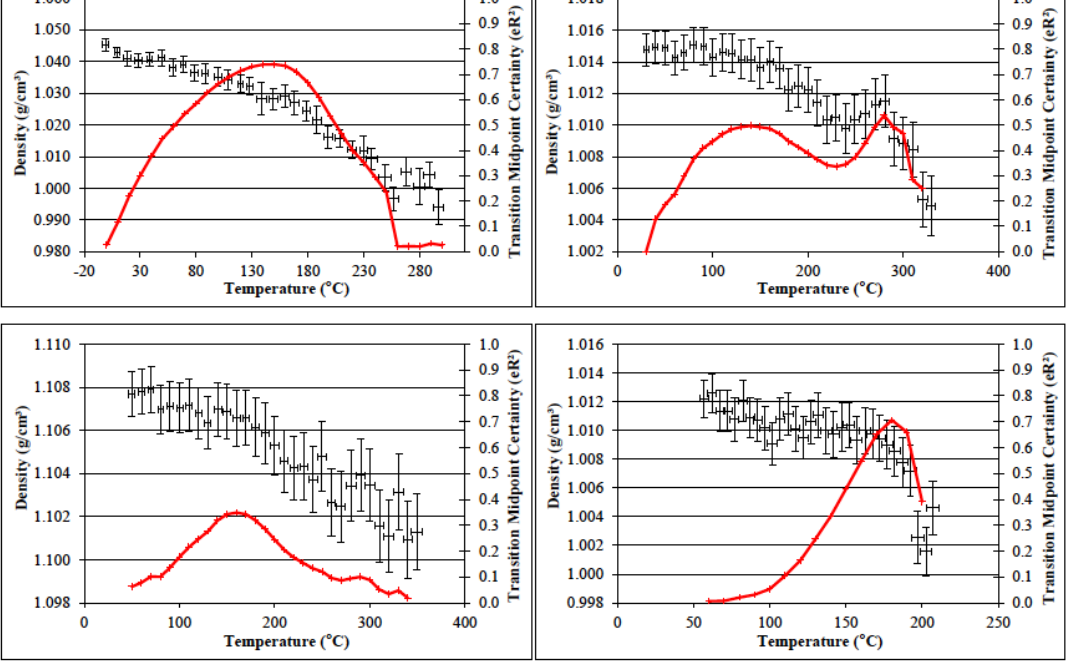
Figure 9. Structure of BD-a monomer, ultimately derived from dicyclopentadiene (showing exo and endo isomers). 4. Conclusions The DSC analyses presented here have allowed determination of a number of properties of the bis -benzoxazine monomers and their respective polybenzoxazines. The first heat of DSC analyses has demonstrated that both BP-a batches, BD-a and BA-a undergo a visible melting stage when